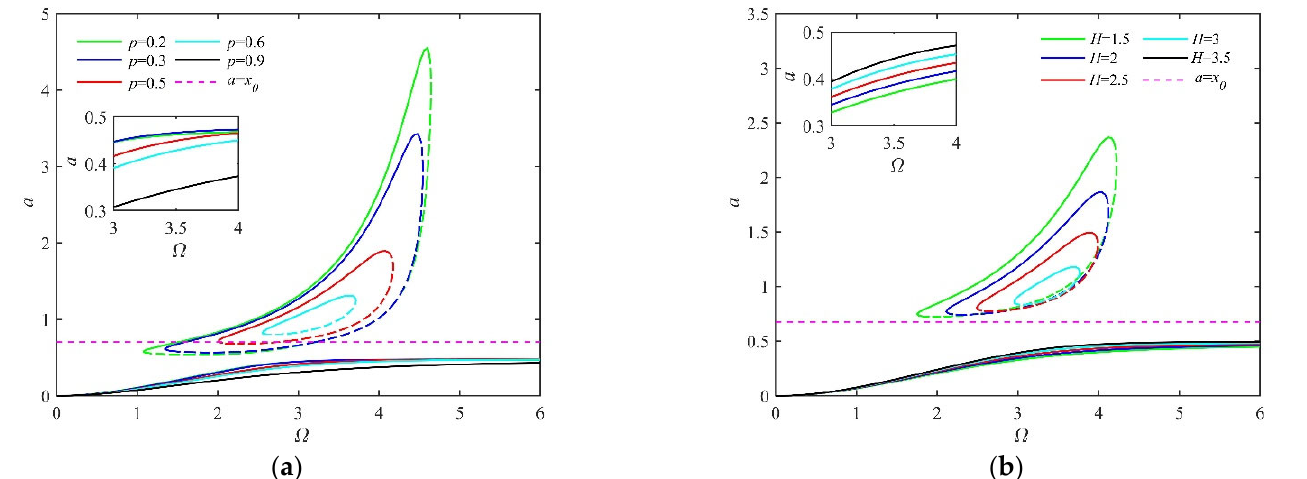
Figure 10. The amplitude frequency response curves with ( a ) H = 1, p = 0.2, 0.3, 0.5, 0.6 and 0.9;